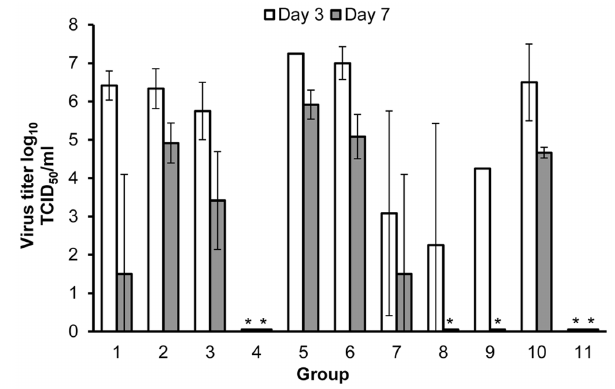
Figure 5. Virus titers in the lung of vaccinated and control mice after challenge with A/Puerto Rico/8/1934 (H1N1) virus. Mice were euthanized on day 3 (white bars) and day 7 (gray bars) and brochoalveolar lavage (BAL) washes were collected. Titers are given as the averages of three BAL washes except for those harvested from group 8 on day 3 and 7 and from groups 5 and 9 on day 3, for which only 2 BAL were available. Only one BAL was harvested from group 9 on day 3. Groups 1–6 were given single vaccinations. Groups 1–8 were given two vaccinations (three weeks apart) of the same mass with each injection. Groups 1, 7, and 11 were given 15 m g rHA, groups 2 and 8 were given 5 m g rHA, and groups 3, 4, and 9 were given 1.7 m g HA. Groups 5, 6, and 10 were given placebo injections. Groups 4, 5, and 11 were given vaccinations formulated with adjuvant. Results are shown as mean 6 SD virus titers in (BAL) washes. *Statistically significant decreases in titers as compared with placebo are indicated. Limit of detection is 10 1.5 TCID 50 /ml.